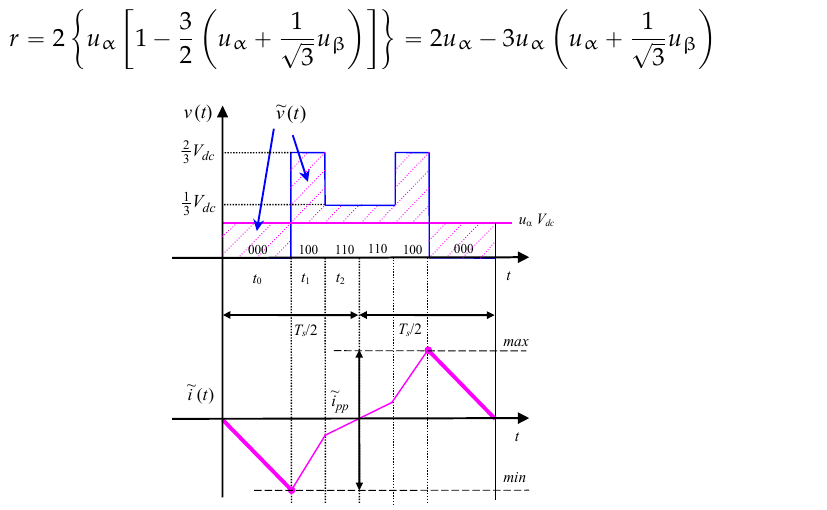
Figure 3. Output voltage and current ripple for DPWM − technique in one switching period (sector I, 0 ≤ u α ≤ 1/3).